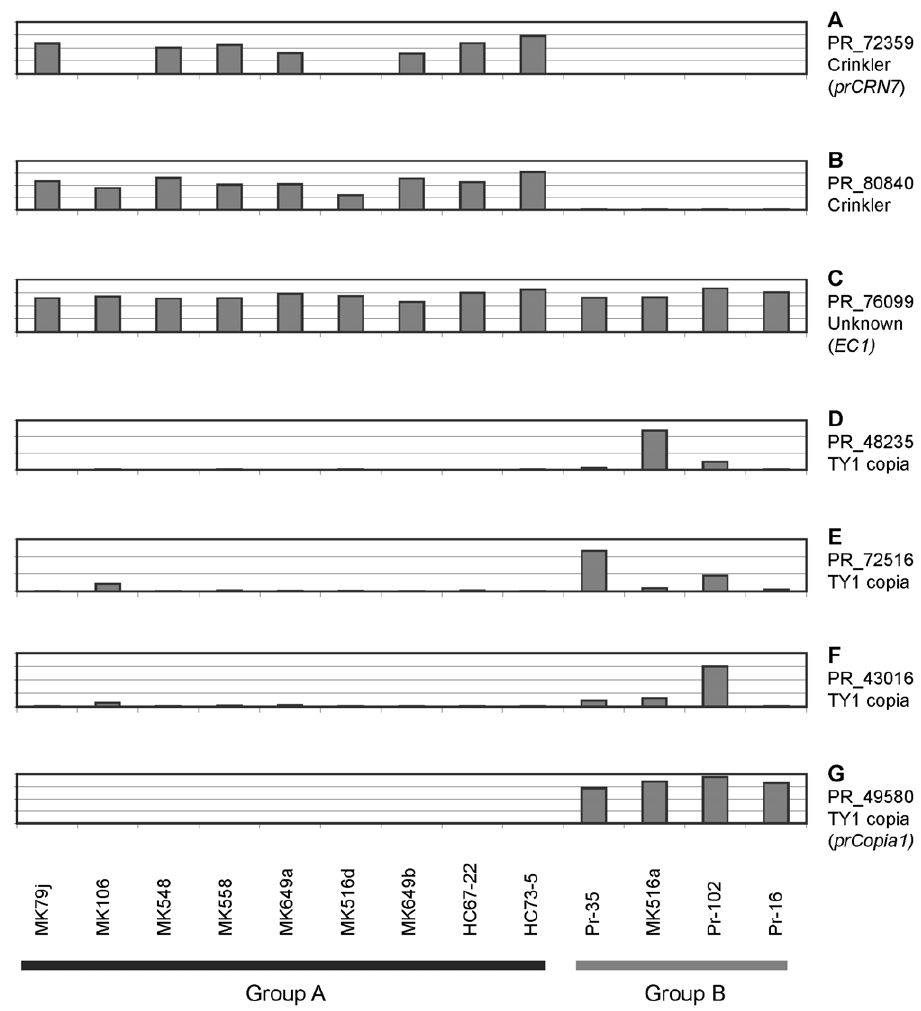
Figure 3. Examples of mRNA microarray profiles of Phytophthoraramorum genes deferentially expressed between group A and group B. Bars are estimates of relative expression levels of mRNA transcripts obtained by RMA. A gene model number and its annotation are shown for each profile. Names for corresponding qPCR markers are shown in parentheses. A) and B) CRN effector homologs. C) a hypothetical gene model PR_76099 used as endogenous control in qRT-PCR. D–G) polyprotein genes of TY1 copia retrotransposons.